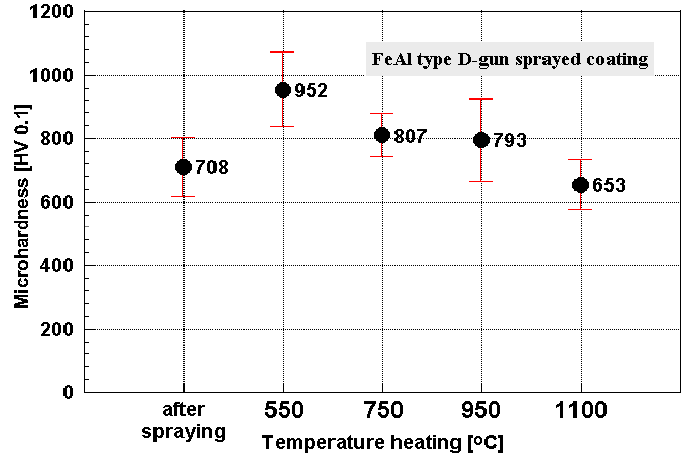
Figure 12. Average microhardness of FeAl type coating versus heat treatment temperature [29].